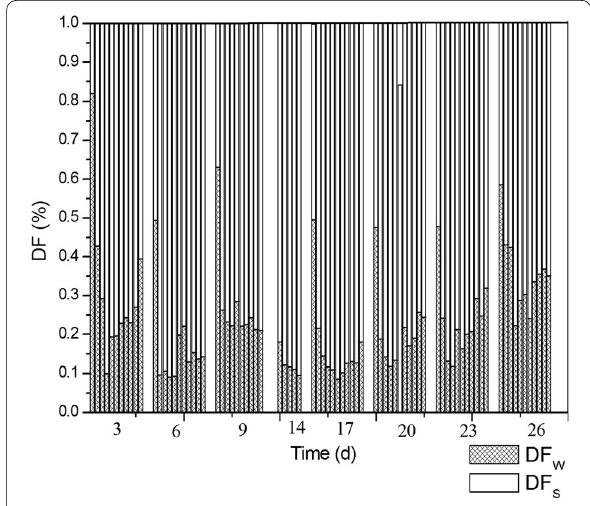
Fig. 6 Distribution of As between fluid phase and solid